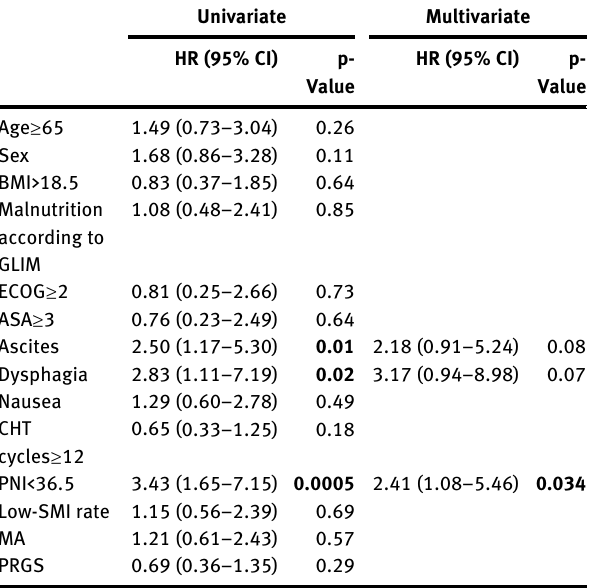
Table  : Univariate and multivariate analysis for overall survival.